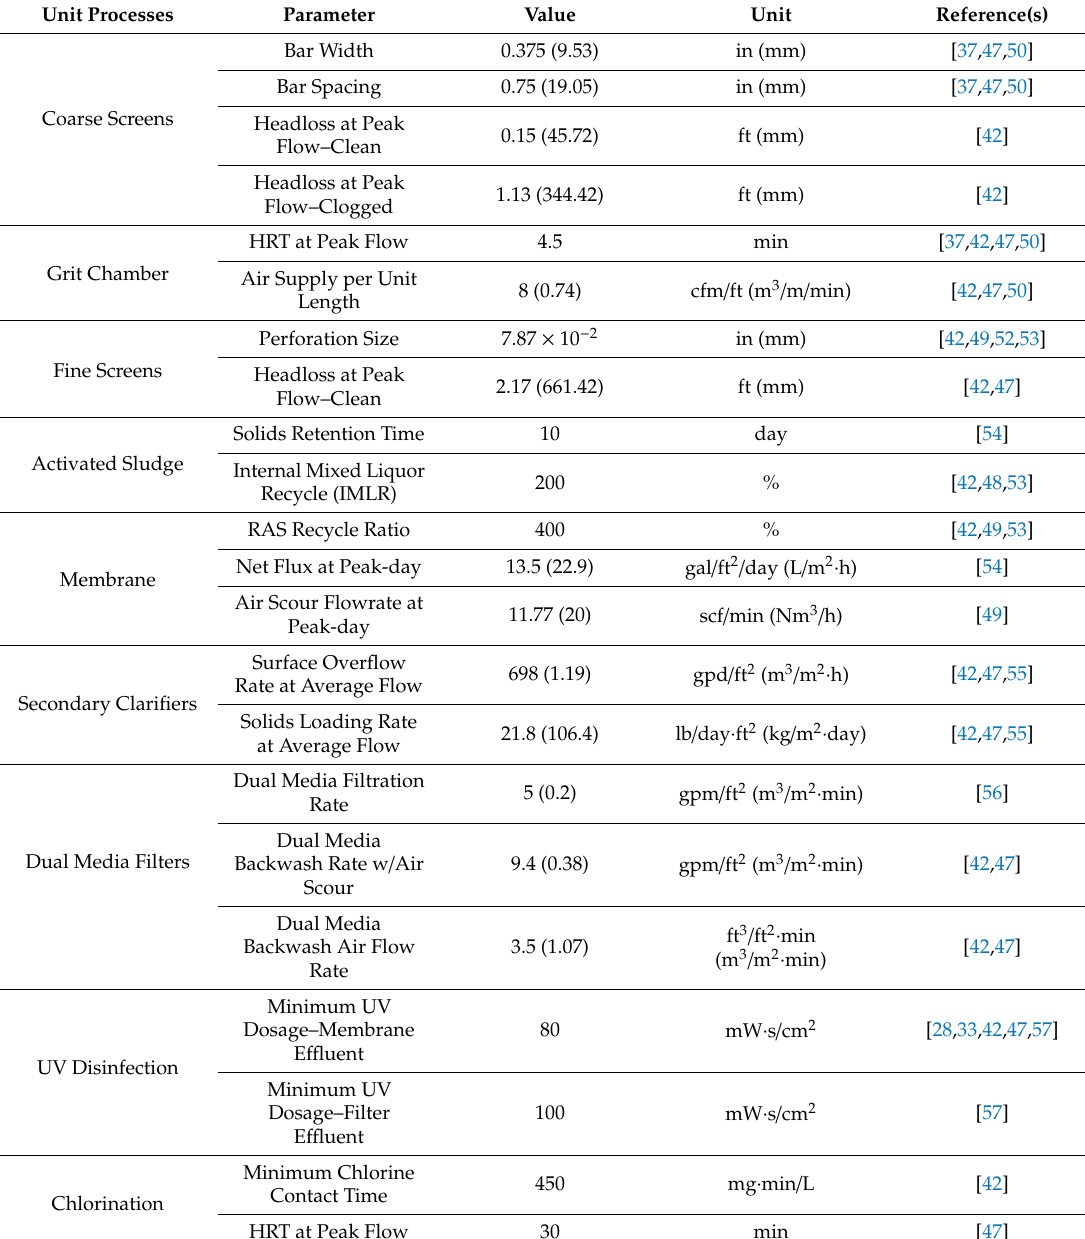
Table 1. Parameters Considered in the Design for the Water Reuse